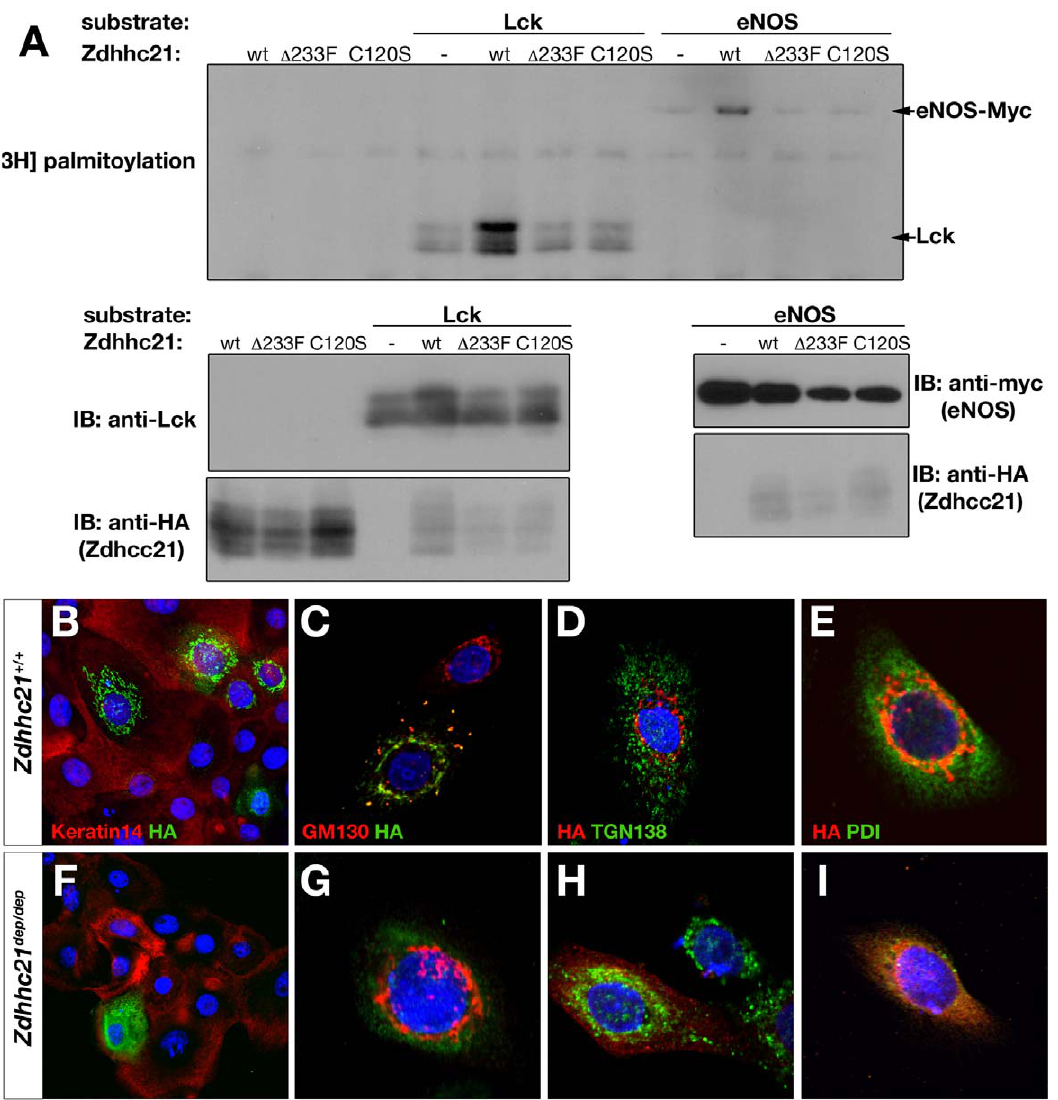
Figure 2. dep mutation disrupts PAT activity and localization of Zdhhc2 1 . (A) [ 3 H] Palmitate fluorography of individual Z dhhc21 (wild type, dep and C120S) HA-tagged constructs co-transfected with eNOS or Lck into HEK293 cells. Increased incorporation of [ 3 H]palmitate into targets is observed with the wild type construct. Neither mutant shows palmitoylation activity above background. Immunoblots using anti-HA (Zdhhc21 constructs), anti-myc (eNOS) and anti-Lck control for loading. (B–I) Immunofluorescence of primary keratinocytes transfected with wild type (B–E) and dep (F–I) HA-tagged Zdhhc21 cDNAs. (B,F) Epidermal marker Keratin 14 (red) and anti-HA (green) antibody staining. While wild type protein shows discrete and compartmentalized localization, the mutant protein is diffuse. (C,G) cis-Golgi network marker GM130 (red) and anti-HA (green) antibody staining. (D,H) trans-Golgi marker Tgn138 (green) and anti-HA (red). (E,I) ER marker PDI (green) and anti-HA (red).